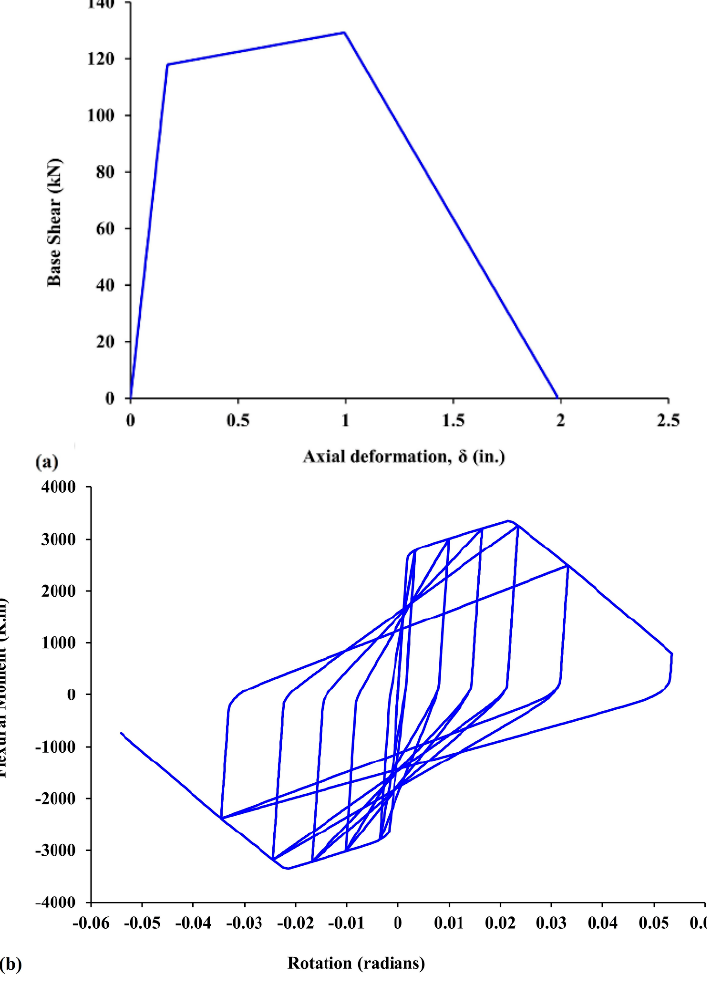
Figure 14. Representing elements’ local behavior; ( a ) axial force-deformation relation for an axial hinge in a monotonic pushover; ( b ) flexural moment-section rotation relation for a flexural plastic hinge through cyclic pushover.